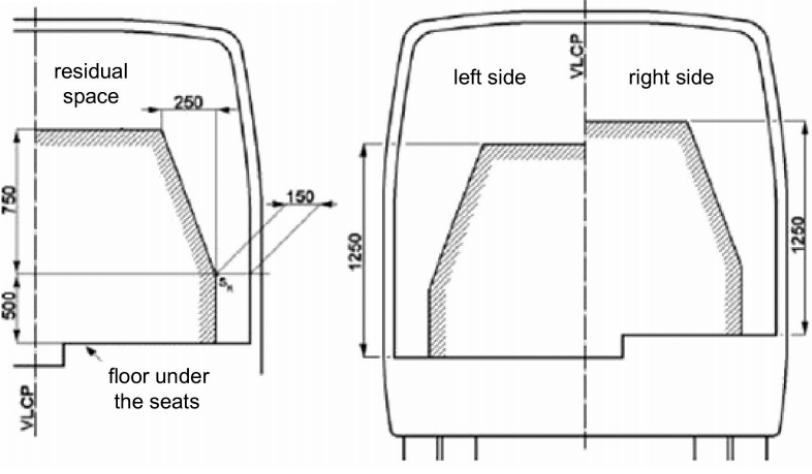
Figure 2. The model of the residual space layout [14].